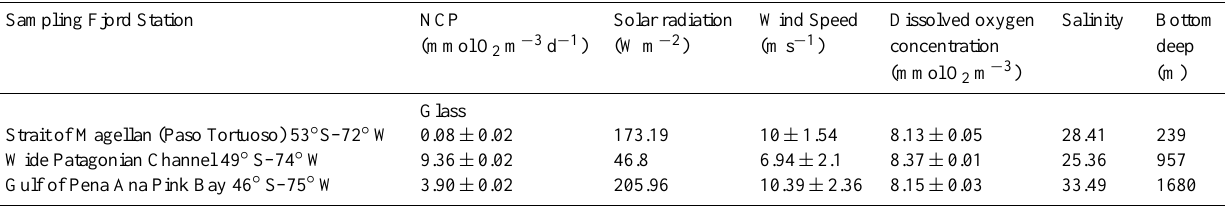
Table 1. Location of the fjord stations, and values at the surface on net community metabolism (NCP ± SE) excluding UVB radiation (glass incubations), and the total incident solar radiation, average wind speed, dissolved oxygen concentration and salinity, and the depth of the